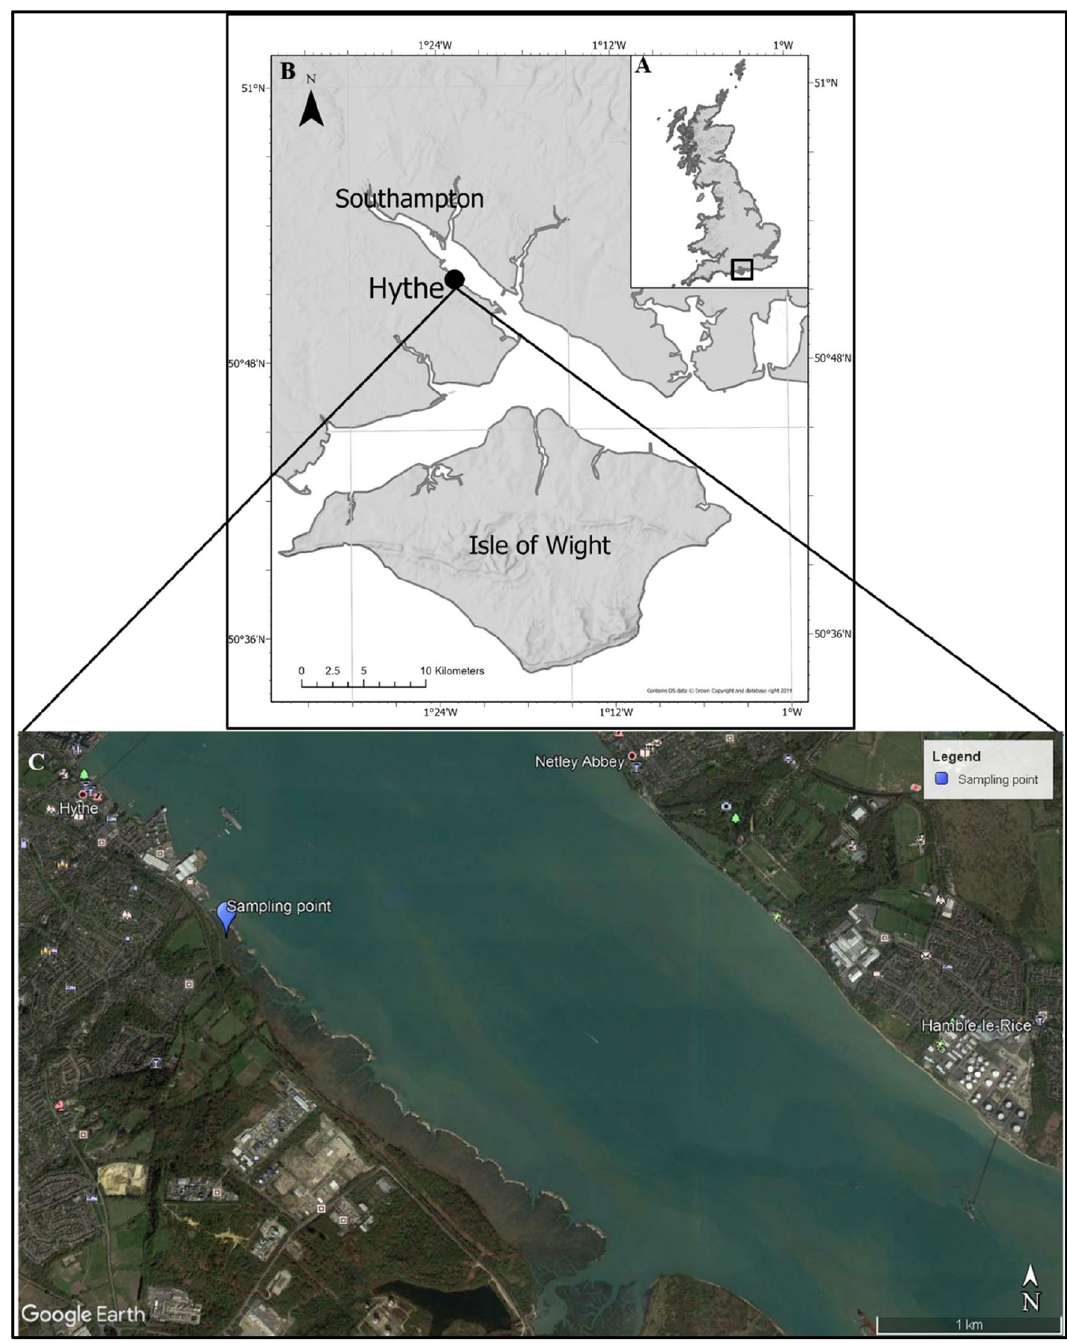
Figure 1. Hythe intertidal zone, Southampton Water, UK: sampling site for the saltmarsh systems examined in the present study. Aerial photographic imagery Copyright 2021 Google. Map data Copyright 2021